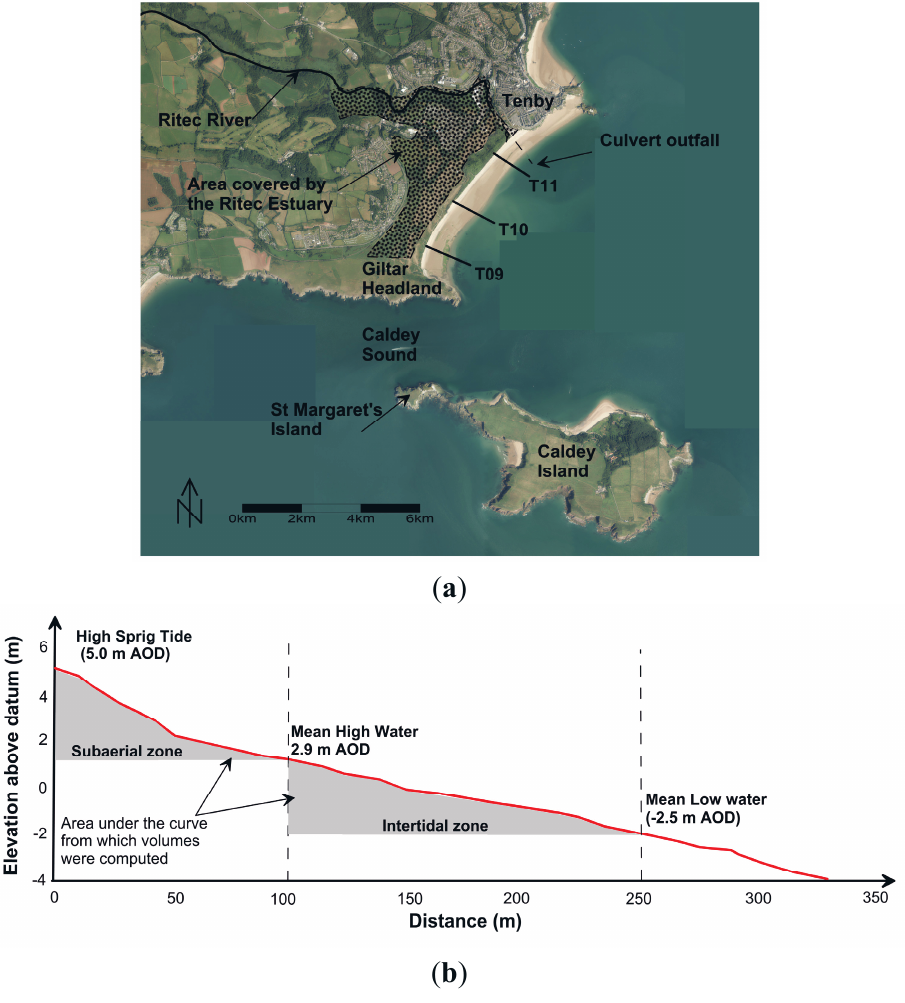
Figure 2. ( a ) Study area location plan including the topographical location of the representative cross shore profiles (T09–T11) from which beach level and volume change were calculated; and ( b ) a definition sketch showing the morphological zones from which comparative beach volumes were